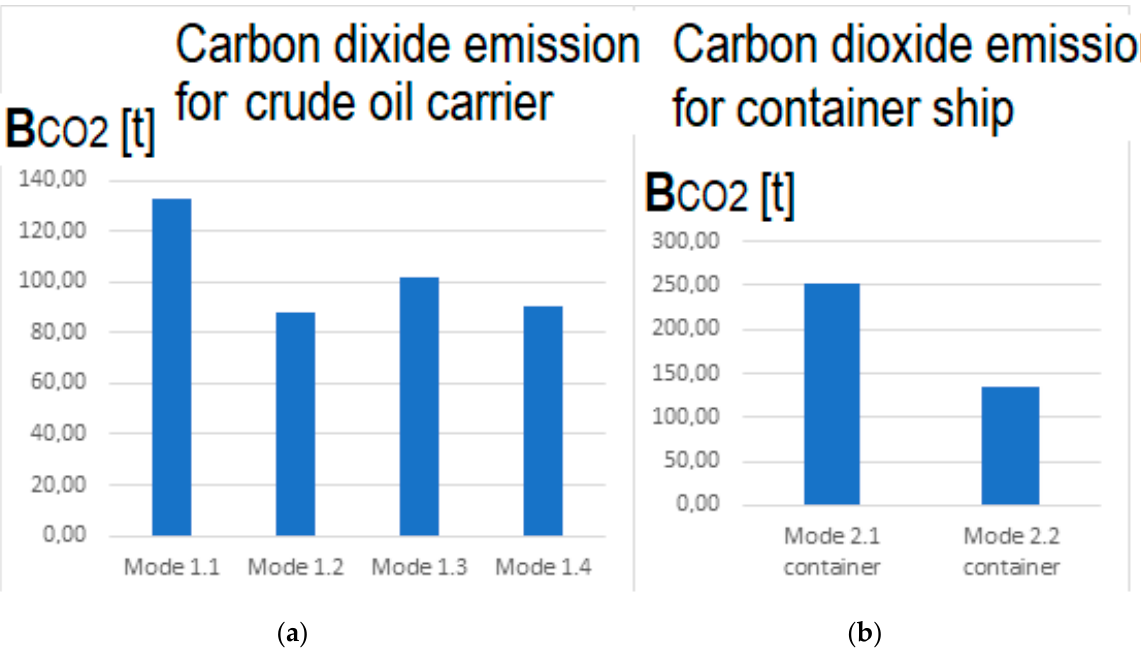
Figure 8. Carbon dioxide emissions: ( a ) total carbon dioxide emission for crude carrier, ( b ) total carbon dioxide emission for container ship.